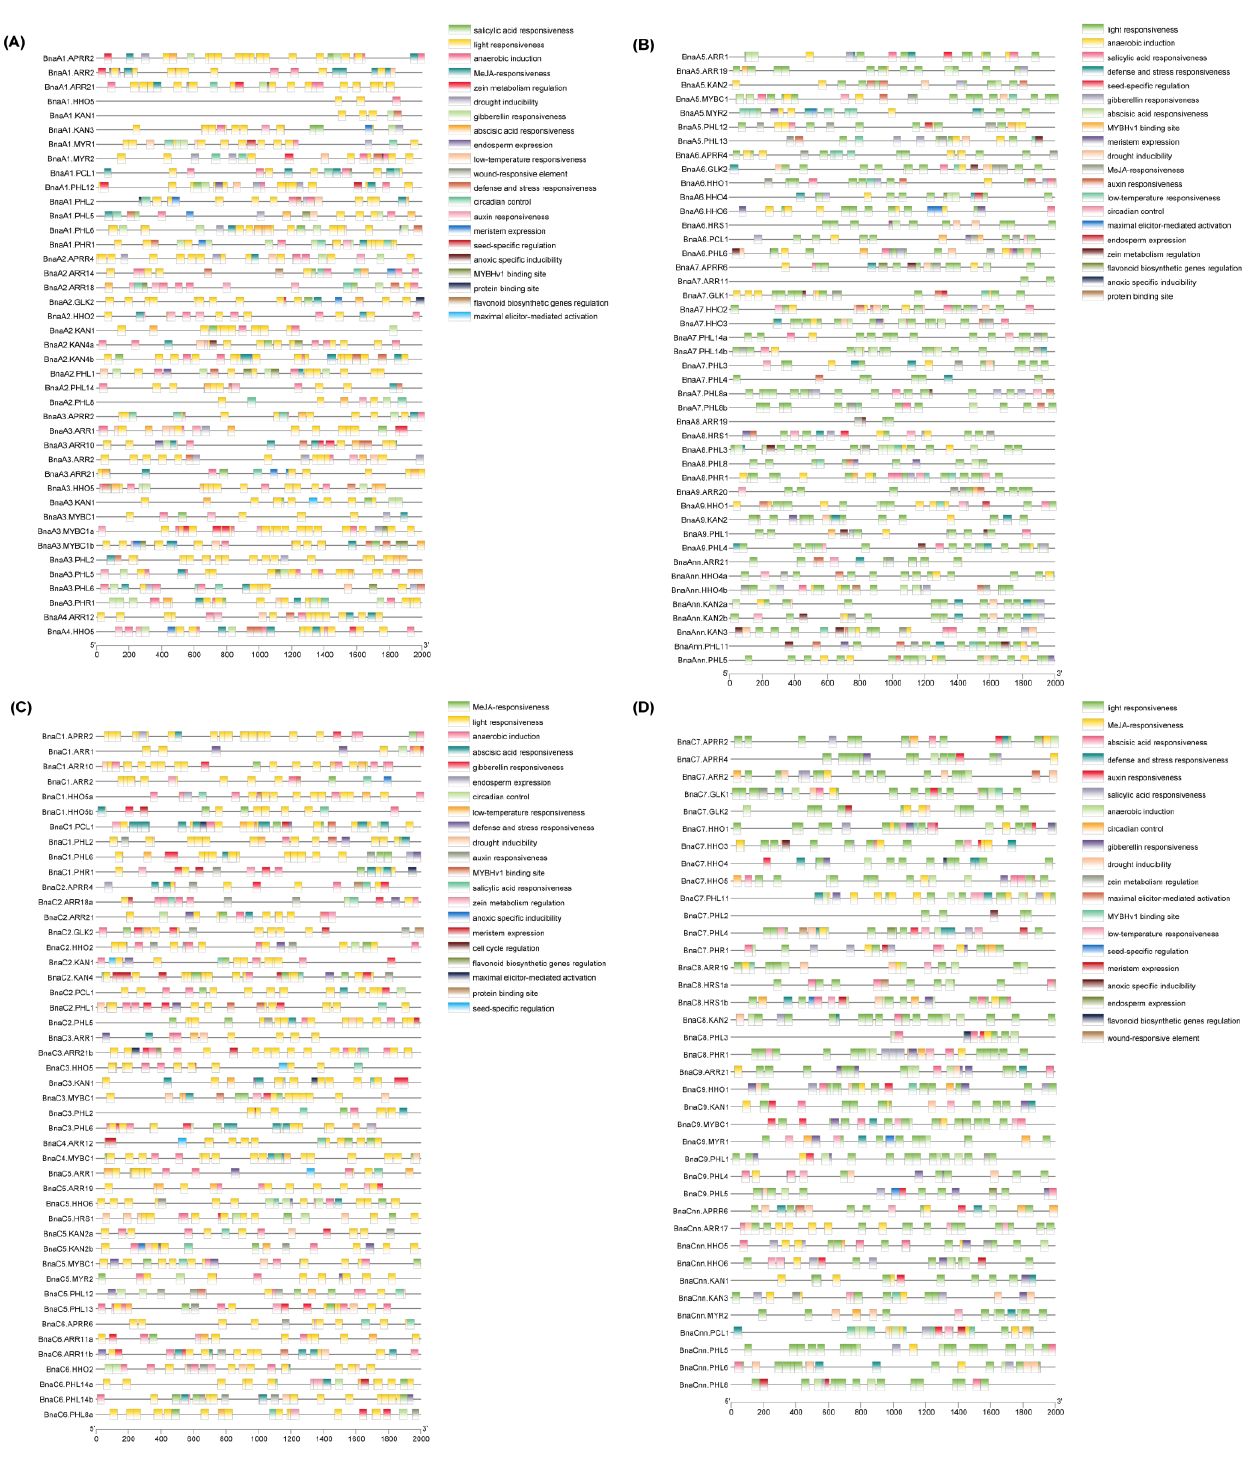
Figure 6. Predicted cis -regulatory elements (CREs) in the promoter regions of BnaGARPs . ( A ) Distribution of the CREs on chrA1 to chrA4. ( B ) Distribution of the CREs on chrA05 to chrAnn. ( C ) Distribution of the CREs on chrC1 to chrC6. ( D ) Distribution of the CREs on chrC7 to chrCnn. The CREs identified by PlantCARE are based on the sequence of 2000 bp upstream of the start codon of BnaGARPs . Different colored rectangles represent different CREs that are potentially involved in the regulation of stress resistance or phytohormone response.